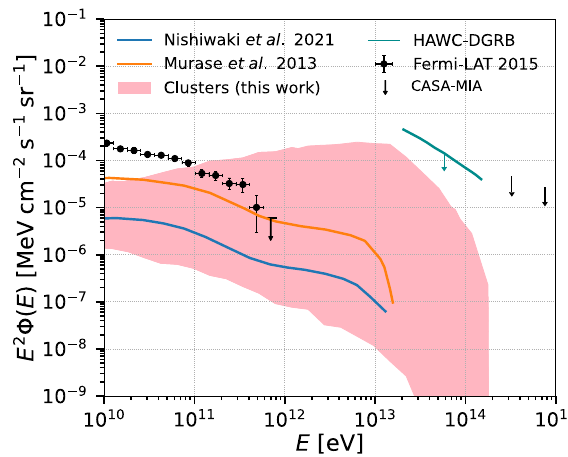
Fig. 4 | Total gamma-ray fl ux for α =2.3 and E max = 10 17 eV over the entire redshiftrangeas,inFig.2(solidblackline). Itiscomparedwiththetotalgamma- ray fl ux that we obtain when accounting for the gas loss of the clusters due to star formation and AGN feedback (black dashed line). The fi gure also shows the DGRB observations from Fermi LAT (error bars correspond to the total uncertainties, statistical and systematic) 66 , as well as the upper limits obtained by HAWC (95% con fi dence level) 31 and CASA-MIA (90% con fi dence level) 32 experiments.